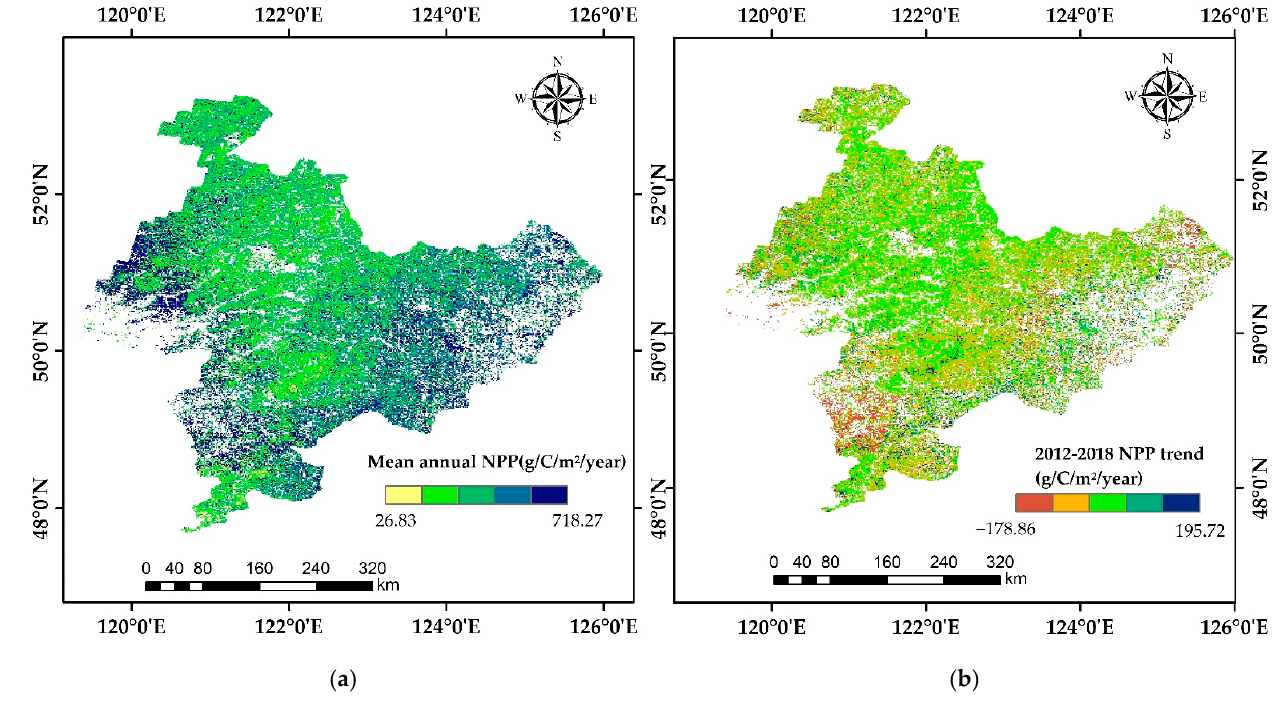
Figure 7. The spatial distribution of average annual NPP ( a ), and its changing trend ( b ) from 2012 to 2018.